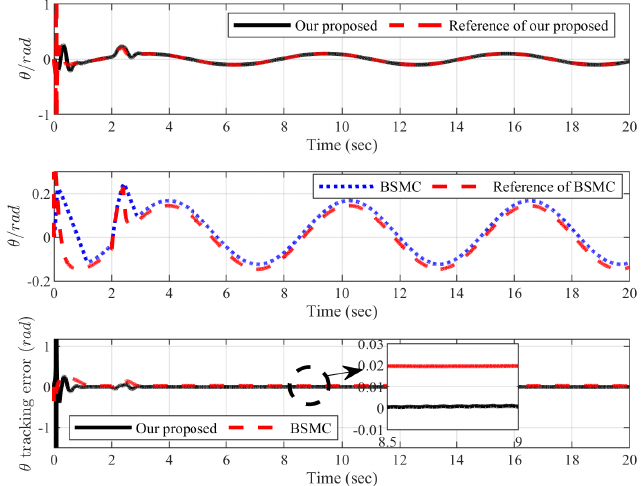
Figure 10. The tracking performance and tracking errors in relation to the pitch